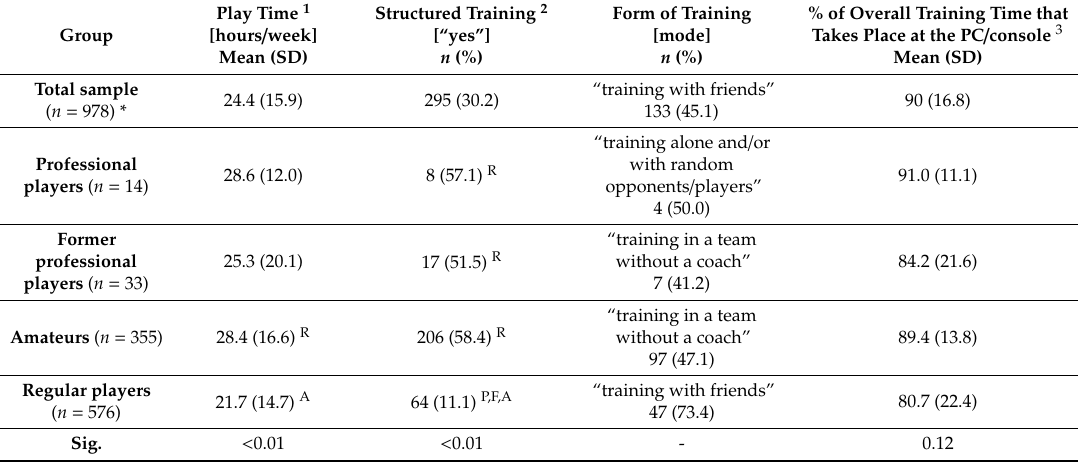
Table 4. Data on video game play time and training